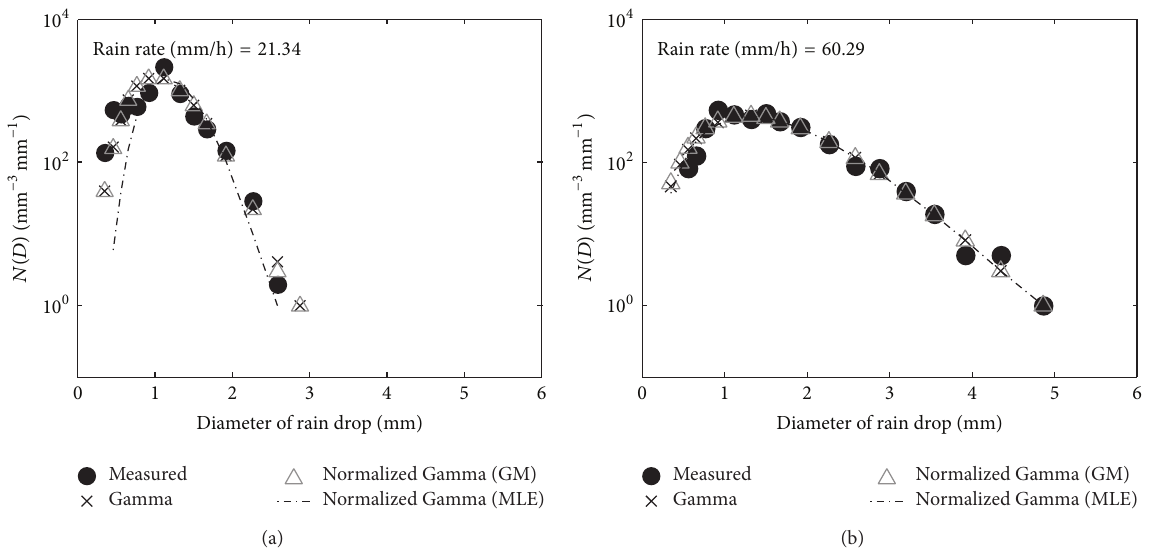
Figure 15: (a) Examples of various models fitting of measured DSD at 21.34 mm/h. (b) As in (a), but for rain rate 60.29